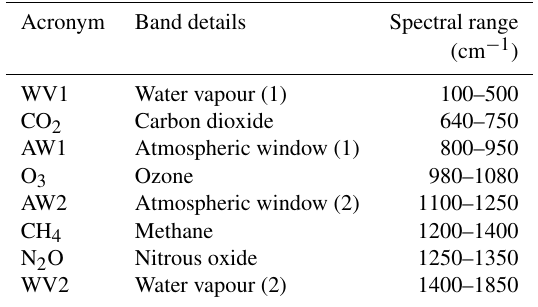
Table 1. Approximated spectral intervals of the atmospheric win- dows and the main absorption bands highlighted in Fig.